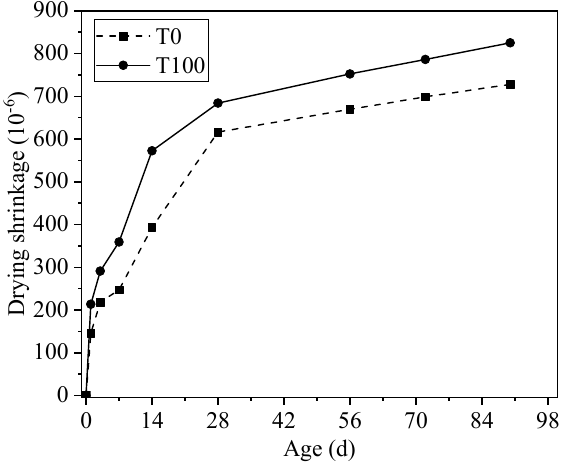
Figure 7. Total shrinkage of concrete with iron tailings sand and river sand.